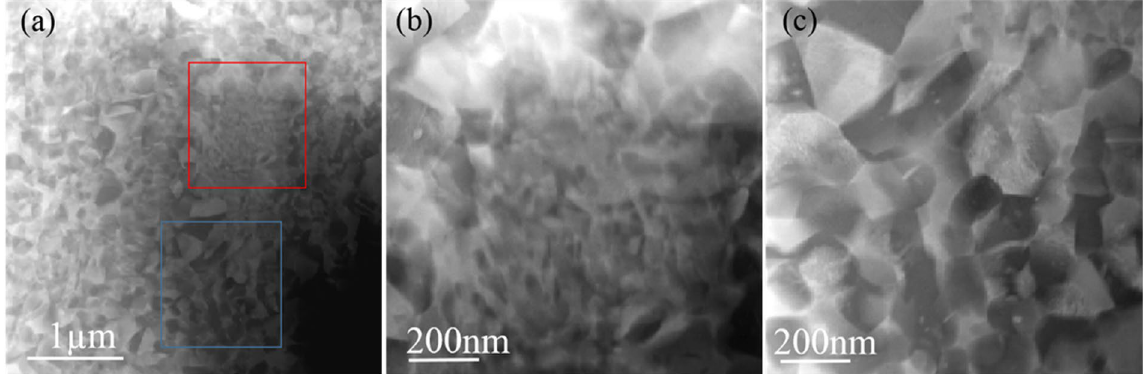
Figure 4. STEM analysis of 820–2 M. ( a ) Low-magnification HAADF image showing heterogeneous nanocrystalline microstructure with relative coarse grain regions and fine grain regions. ( b ) and ( c ) High magnification HAADF images from the red and blue square box marked regions in ( a ), respectively.